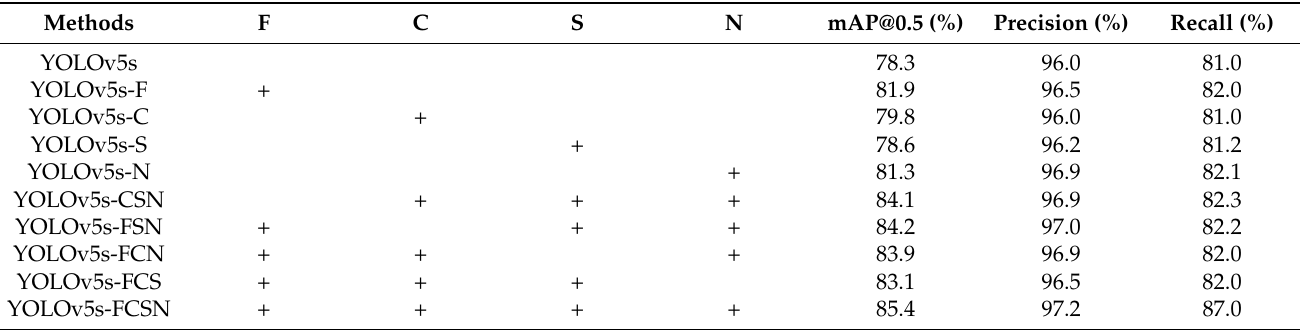
Table 5. Ablation experiments after the introduction of different improved methods. “+” represents the introduction of this